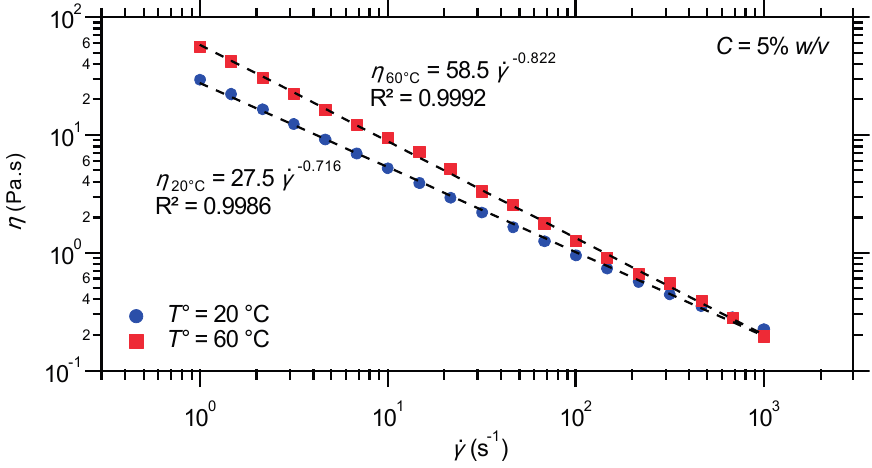
Figure 10. Shear rate dependence of steady shear viscosity for a hydrogel prepared from the PS- b -PNIPAAm- b -PDMAEMA-tpy copolymer and Ni(II) ions, at different